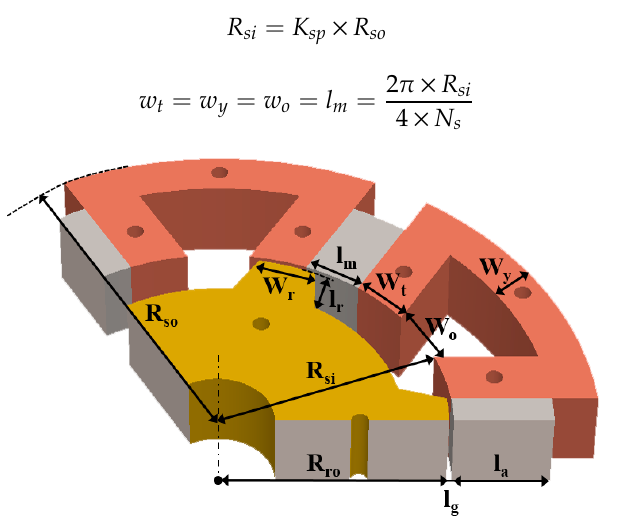
Figure 2. The symbolic description of the as ‐ designed 6/5 FSPM.